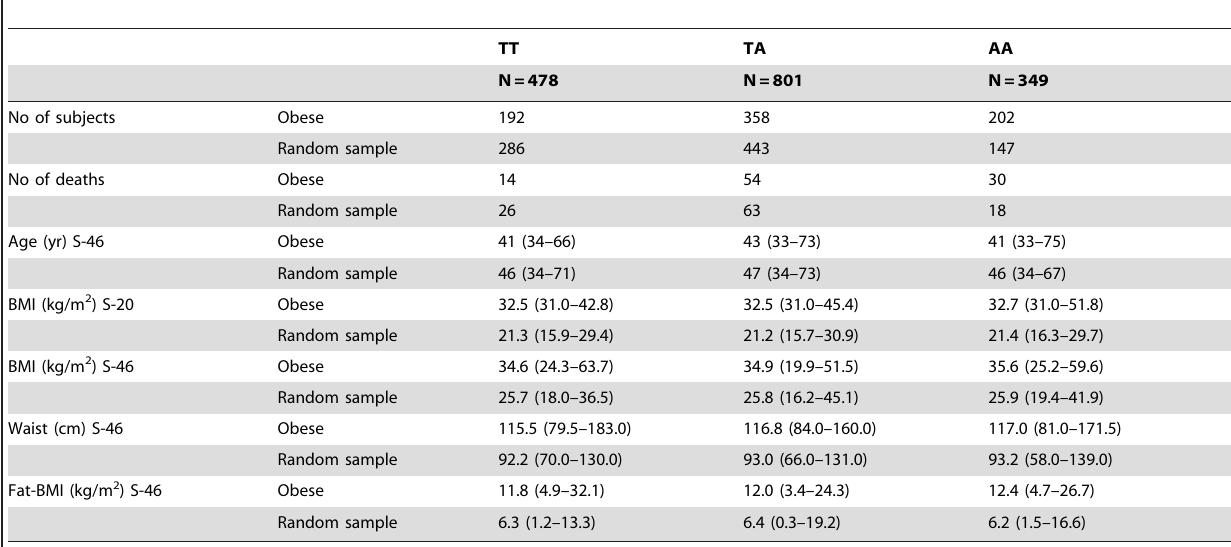
Table 1. Distribution of age and anthropometrics given as median and range of 1,628 Danish men according to genotype for FTO